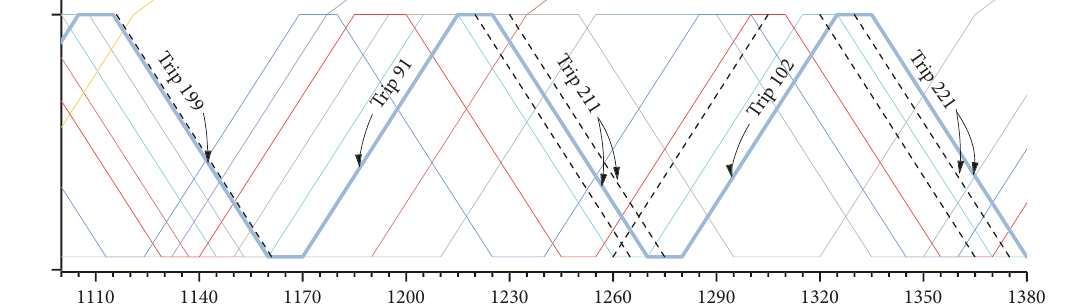
Figure 6: The more details of modifications for the timetable in Figure